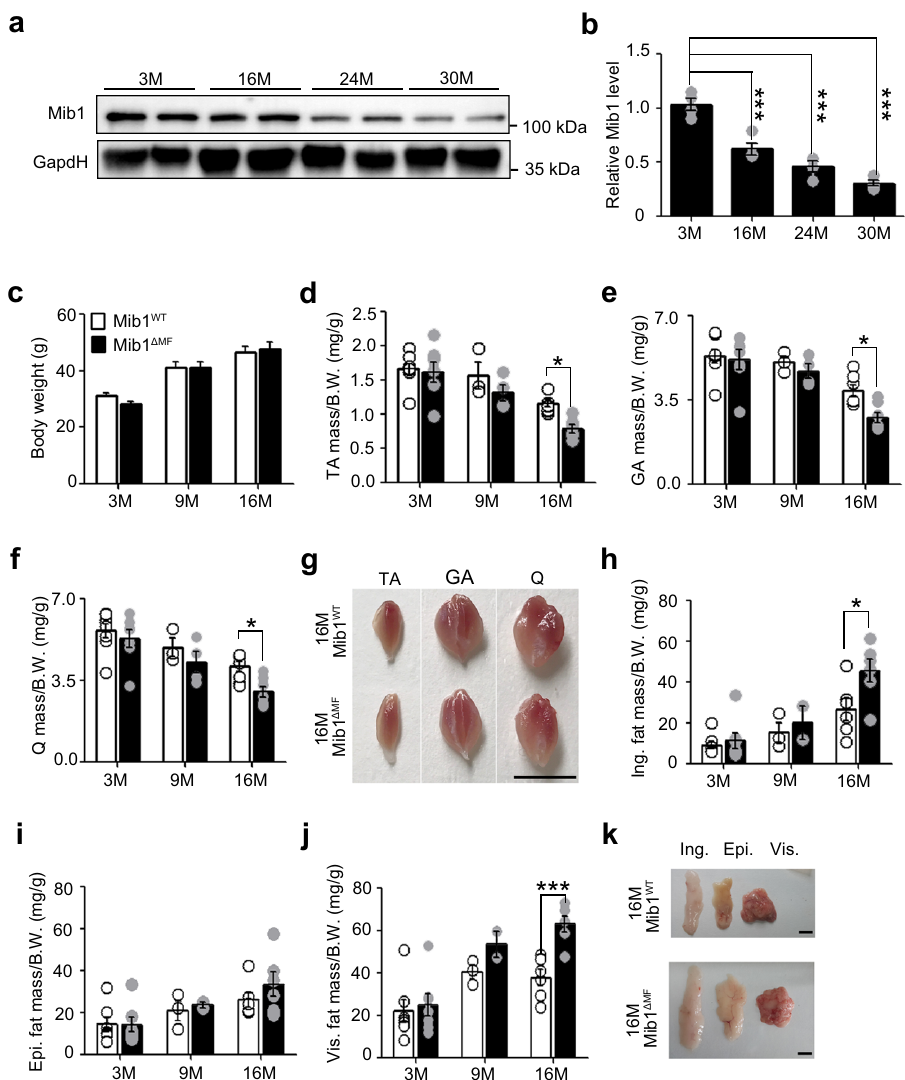
Fig. 1 Age-associated muscle atrophy in Mib1 Δ MF mice. a , b Immunoblotting (IB) of Mindbomb-1 (Mib1) from wild-type (WT) gastrocnemius (GA) muscles at indicated ages ( a ) and quanti fi cation of western blot analysis ( b ). The intensity of Mib1 expression at indicated ages (M; month) was quanti fi ed by densitometry. c – f Body weights ( c ) and relative tibialis anterior (TA) ( d ), GA ( e ), and quadricep (Q) ( f ) muscle masses to body weights of Mib1 f/f (Mib1 WT ) and MCK-Cre;Mib1 f/f (Mib1 Δ MF ) at indicated ages. g Gross morphology of hindlimb muscles (TA, GA, and Q muscles) from 16-month-old Mib1 WT and Mib1 Δ MF mice. Scale bars, 0.5 cm. h – j Inguinal (Ing) fat ( h ), epididymal (Epi) fat ( i ), and visceral (Vis) fat ( j ) masses to body weights of Mib1 WT and Mib1 Δ MF at indicated ages. k Gross morphology of fat (Ing, Epi, and Vis fats) from 16-month-old Mib1 WT and Mib1 Δ MF mice. Scale bars, 1 cm. Data are presented as means ± s.e.m. Data are shown as representatives of at least three independent experiments. n = 4 ( b ), n = 11, 18, and 17 for 3-, 9-, and 16-month-old Mib1 WT mice and 16, 18, and 16 for 3-, 9-, and 16-month-old Mib1 Δ MF mice, respectively ( c ); n = 8, 3, and 7 for 3-, 9-, and 16-month-old Mib1 WT mice and 7 for 3-, 9-, and 16-month-old Mib1 Δ MF mice, respectively ( d – f , h – j ); n = 7, 3, and 6 for 3-, 9-, and 16-month-old Mib1 WT mice and n = 7, 4, and 6 for 3-, 9-, and 16-month-old Mib1 Δ MF mice, respectively ( d – f , h – j ). One-way ANOVA for ( b ). Two-way ANOVA for ( c – f , h – j ). * P < 0.05; *** p <